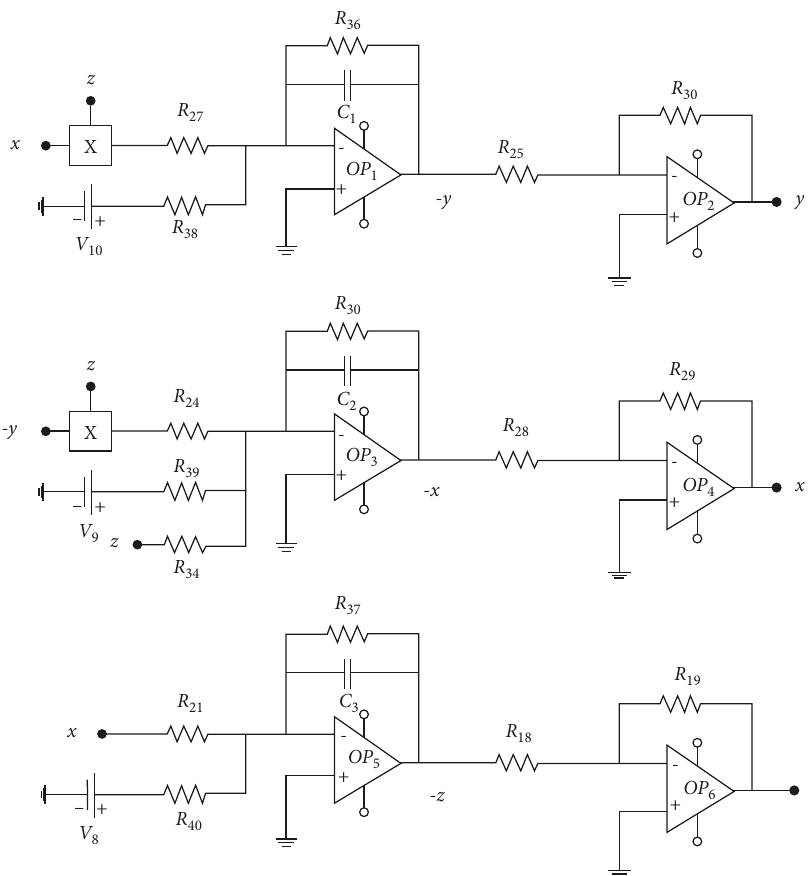
Figure 15: The schematic diagram of the PMSM described by system (1a and